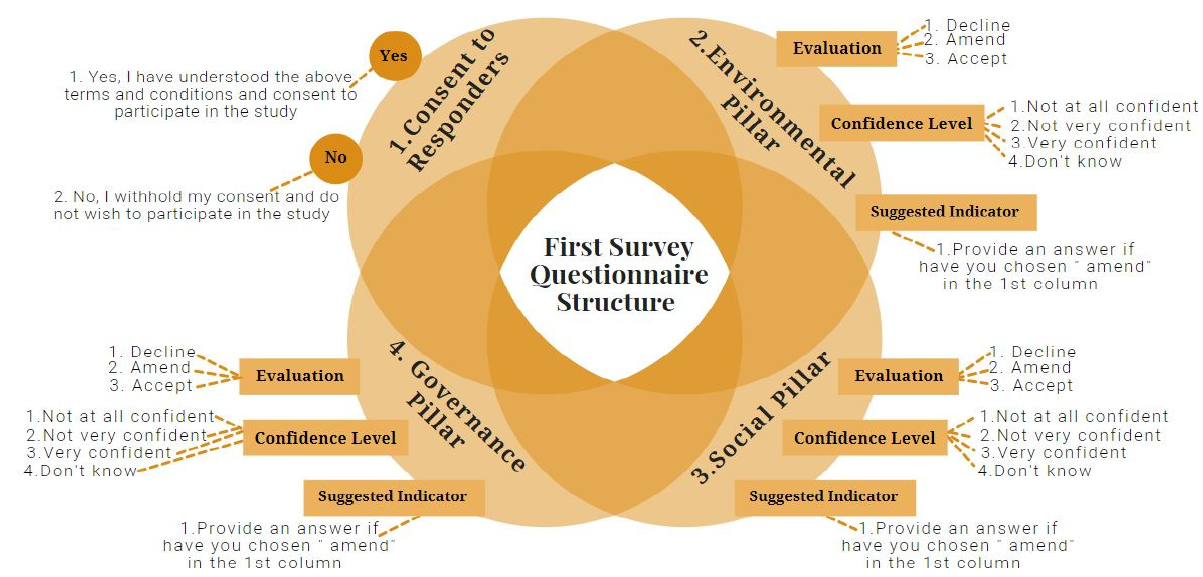
Figure 1. The research instrument used in the first survey. Source: Matemane (2022).